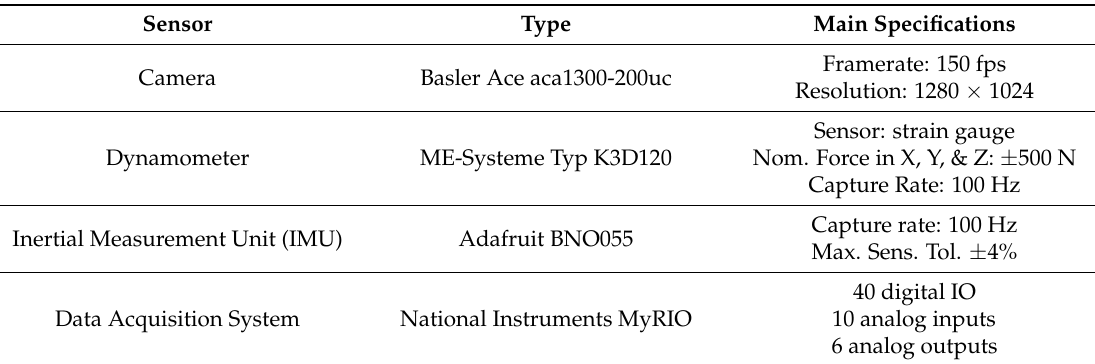
Table 1. Measurement equipment applied in the test stand.